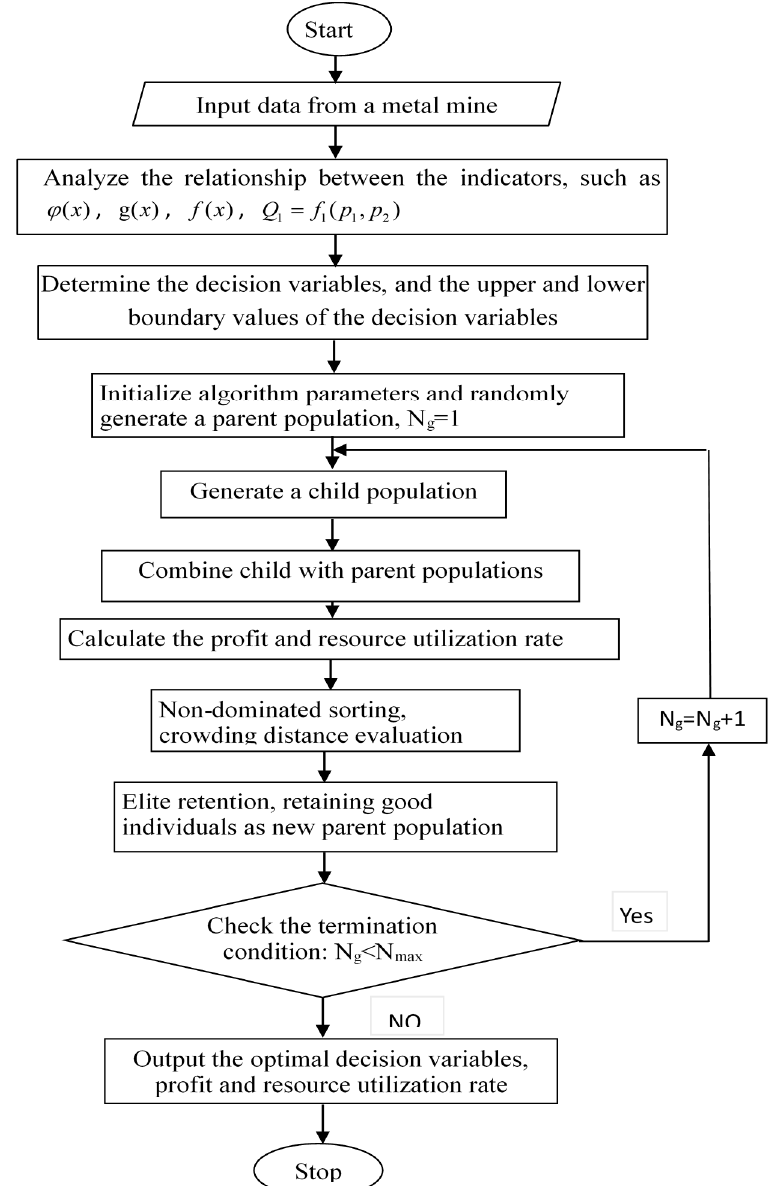
Figure 2. Flowchart of production process optimization of metal mines using the Non-Dominated Sorting Genetic Algorithm (NSGA-II).